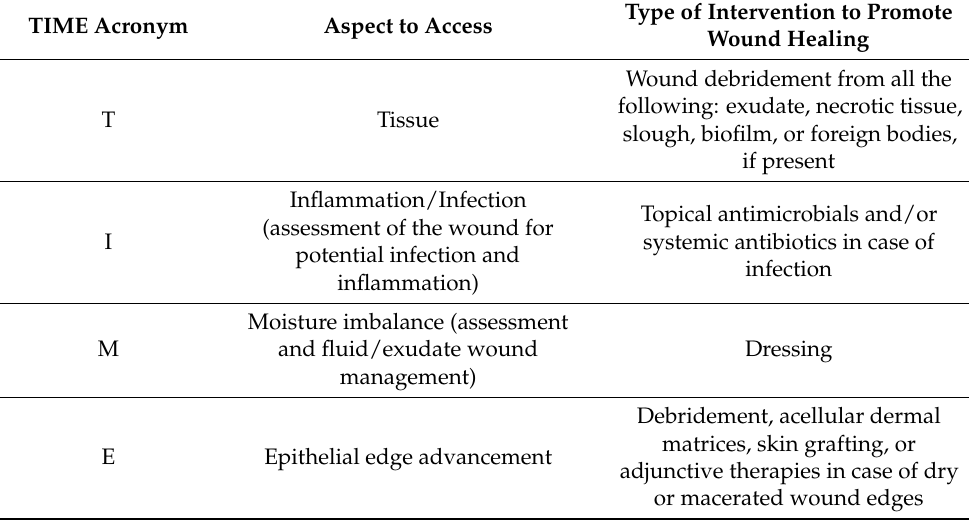
Table 1. The TIME concept